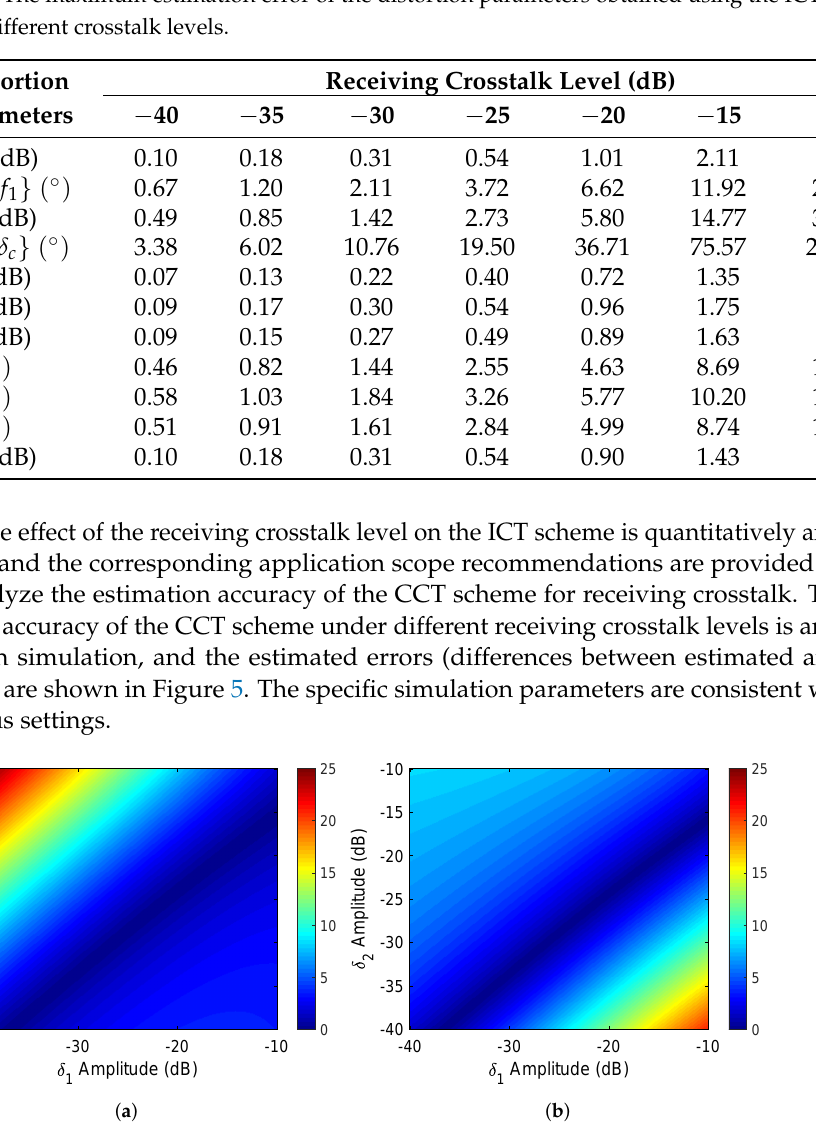
Figure 5. The estimated error of the received crosstalk using the CCT scheme under different received crosstalk distortion conditions. ( a ) estimated error of δ 1 . ( b ) estimated error of δ 2